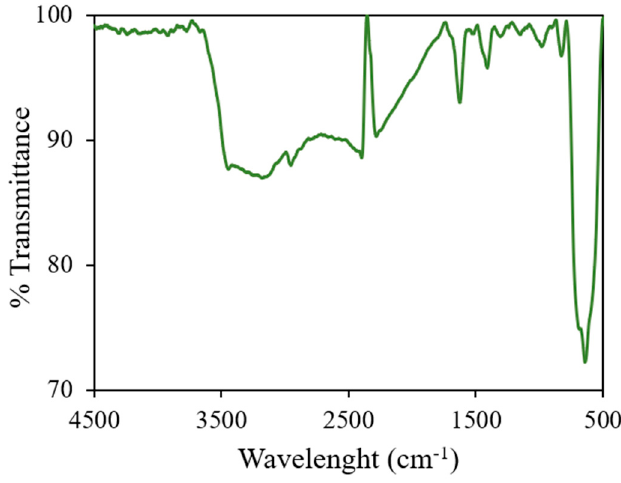
Figure 4. FTIR spectra of synthesized magnetite nanoparticles.